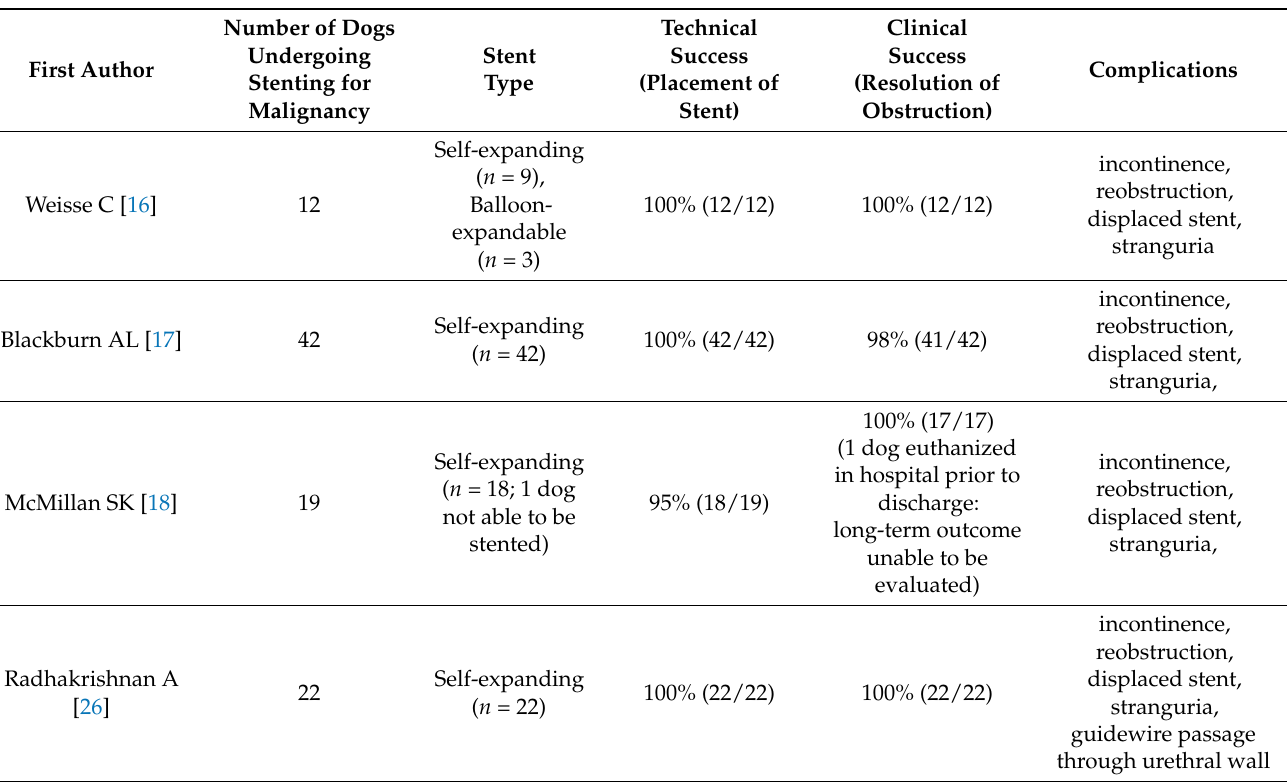
Table 1. Summary table of major studies evaluating urethral stent placement in